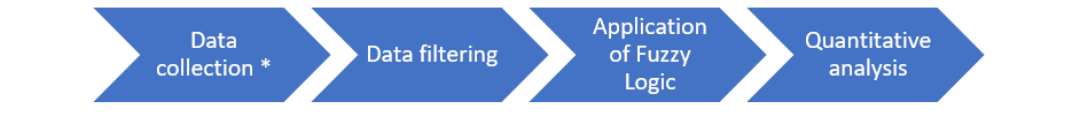
Figure 2. General diagram illustrating the methodology used in the present study. * Data from school year 2018–2019 was used.